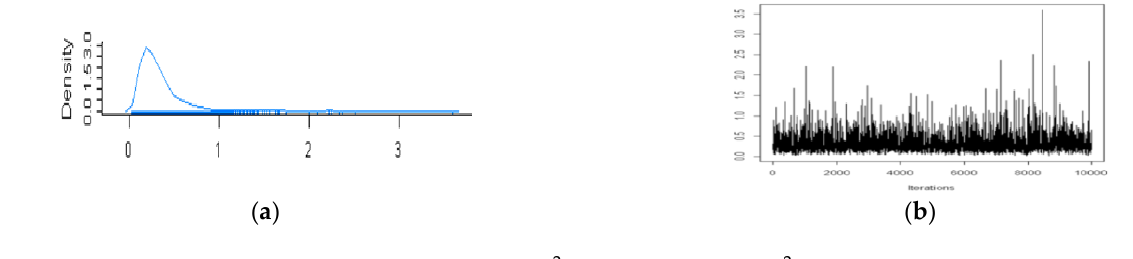
Figure 6. ( a ) Density plot of τ 2 and ( b ) trace plot of τ 2 (case